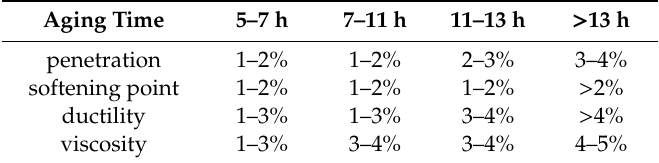
Table 4. E ff ect of di ff erent WCO contents on physical properties in di ff erent aged asphalts.